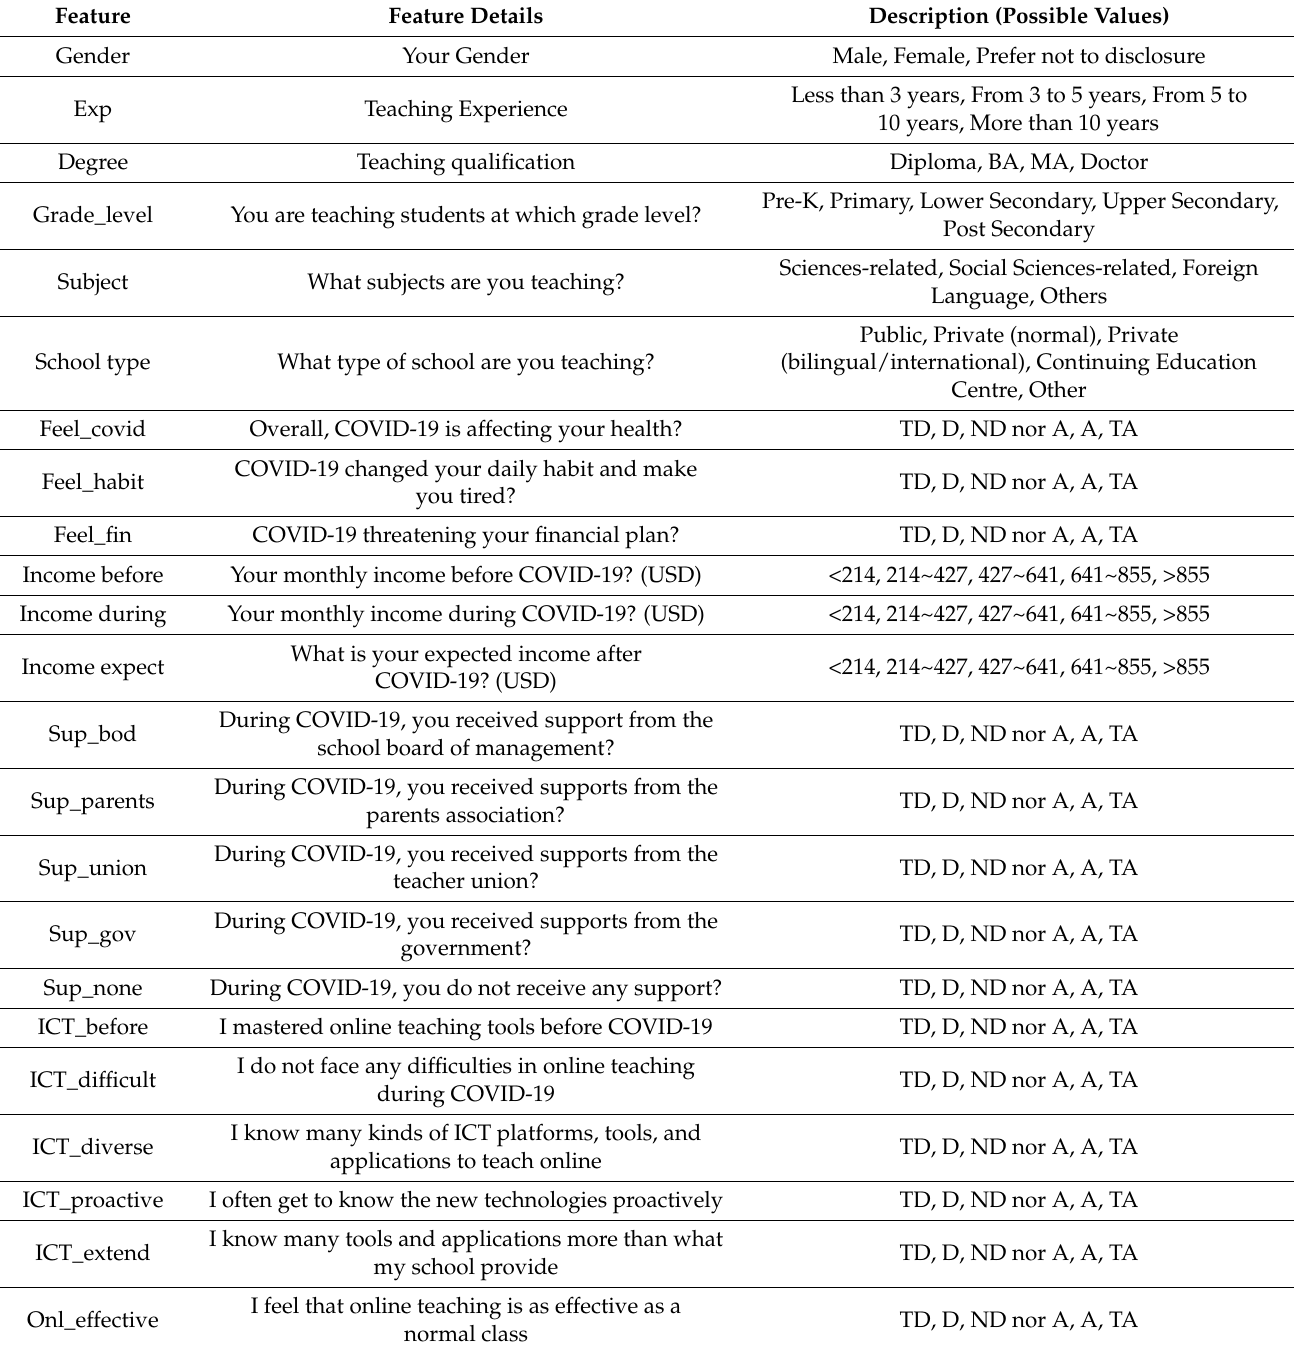
Table 2. Details of Benchmark Vietnam’s Teachers’